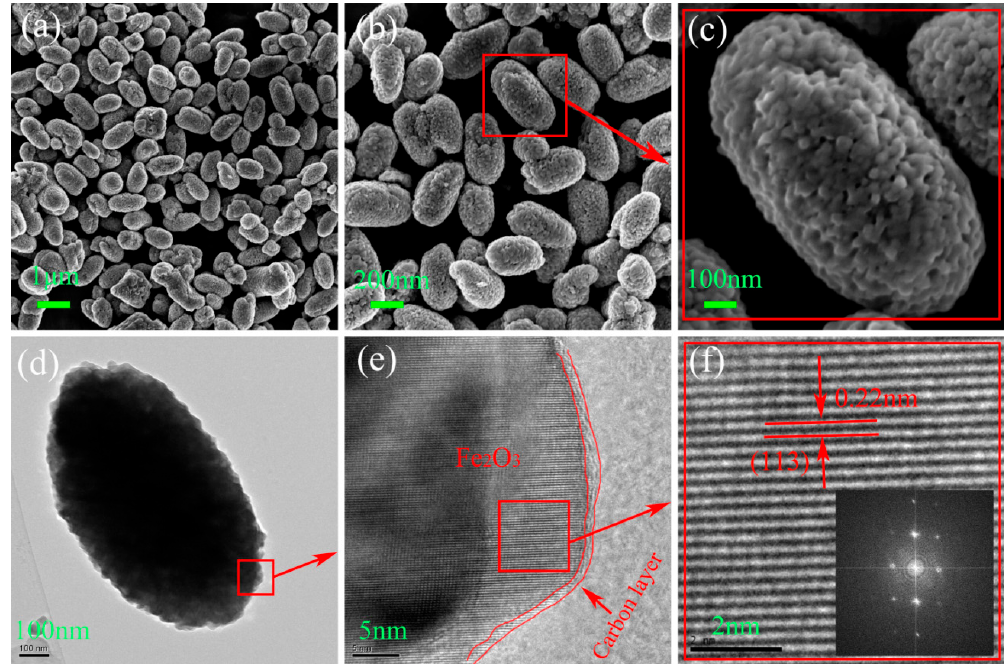
Figure 4. ( a – c ) field scanning electron microscopy (FESEM) and ( d – f ) transmission electron microscopy (TEM) images of α -Fe 2 O 3 @C nanoparticle composite. The insert is the selected area electron diffraction (SAED) image.